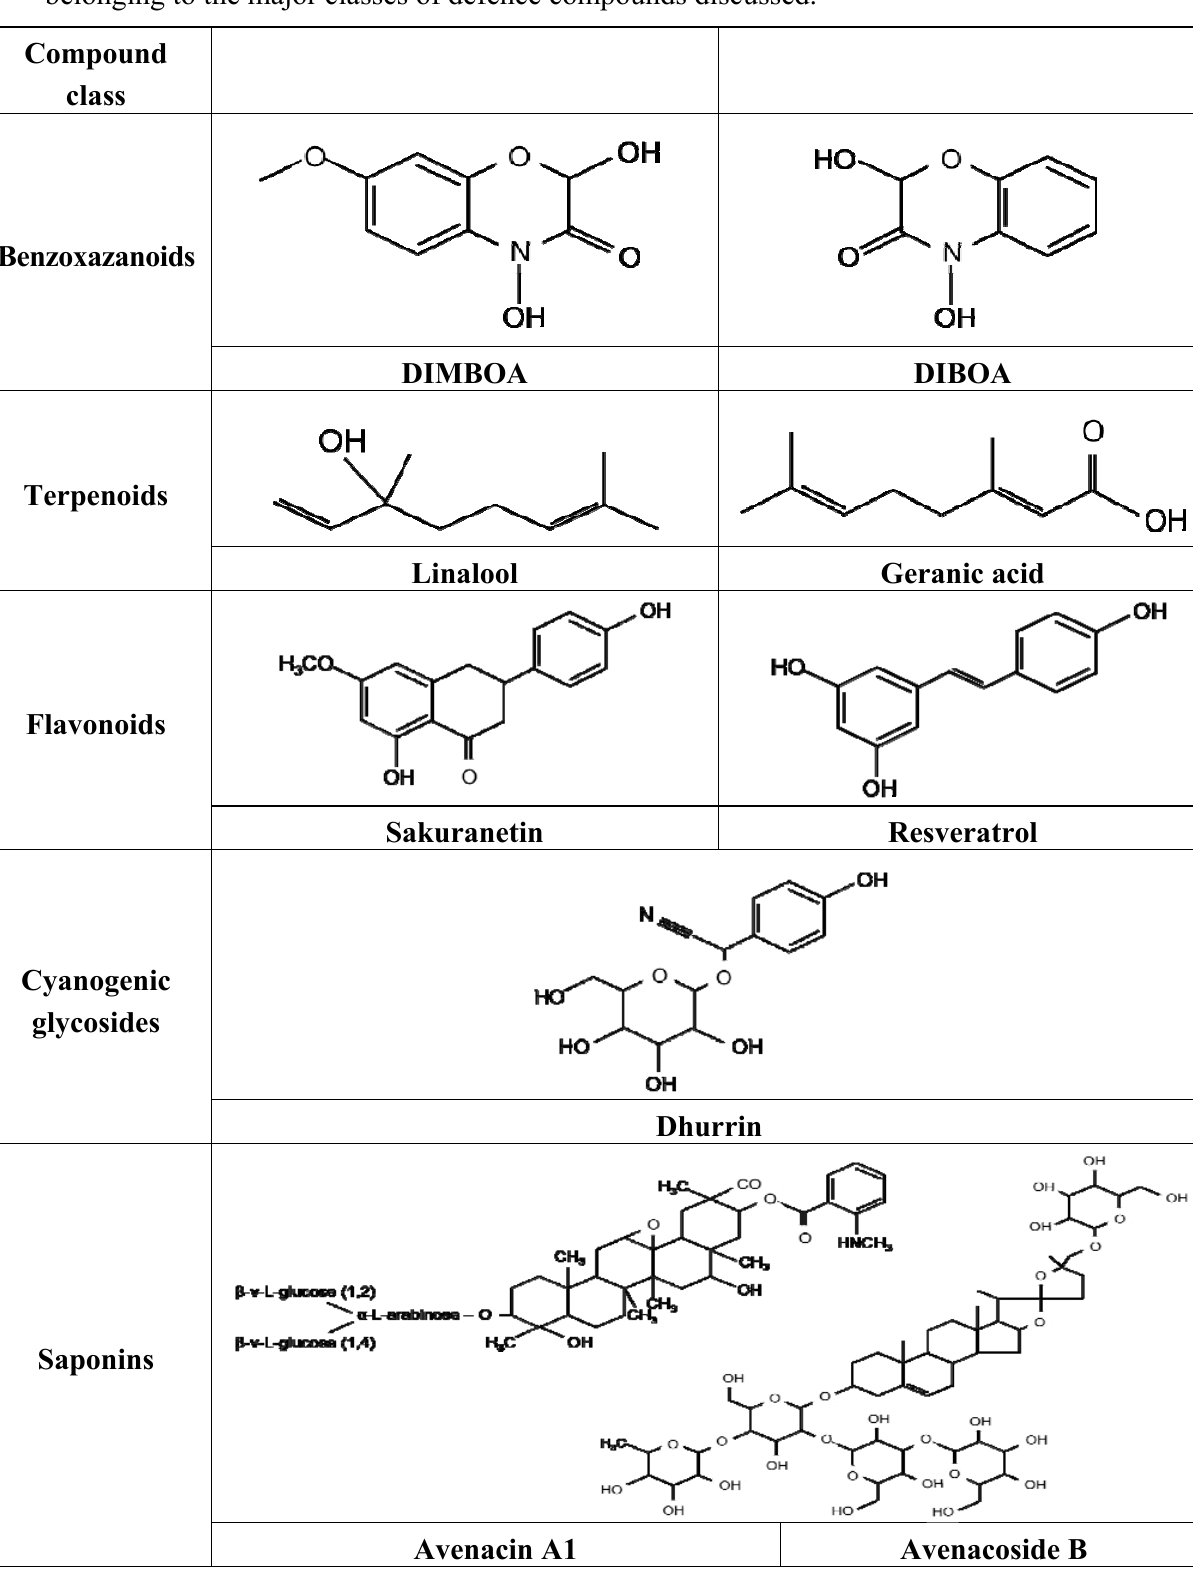
Table 1. Diagram illustrating the structures of a number of plant secondary metabolites belonging to the major classes of defence compounds